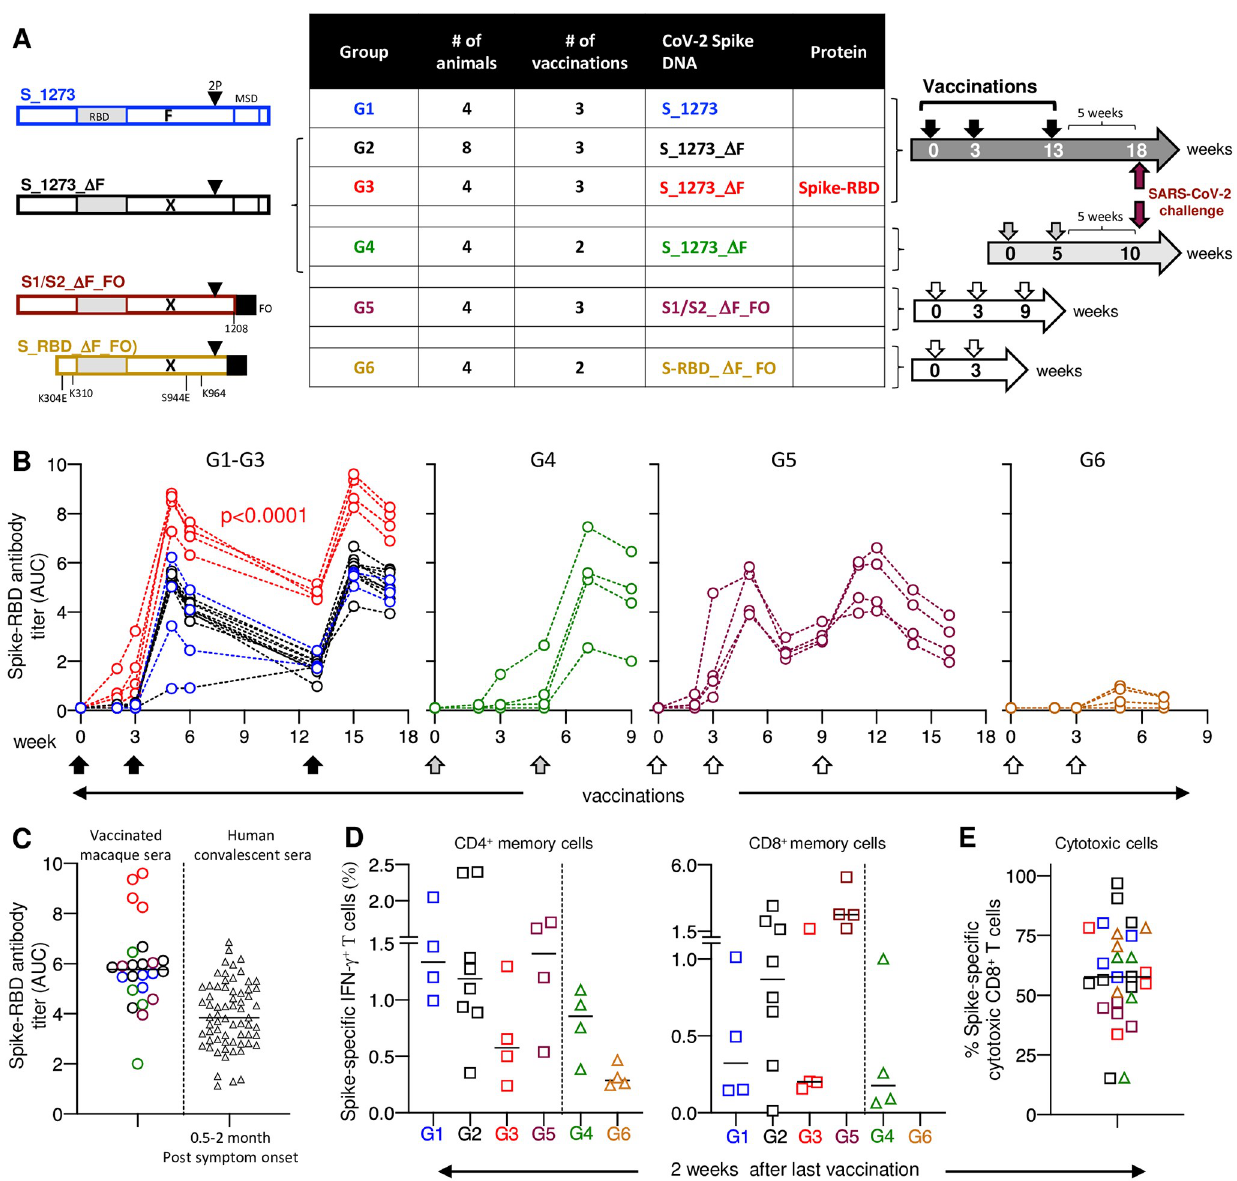
Fig 1. Vaccination-challenge study in macaques. ( A ) Cartoon depicts the Spike immunogens produced from the different DNA-based vaccines and the vaccination scheme of the 6 vaccine groups. The animals from G1-G4 were challenged 5 weeks after the last vaccination (indicated by maroon arrow). Blood was collected at different time points after each vaccination. ( B ) Anti-Spike-RBD antibodies were measured over time by ELISA in the vaccinated macaques and shown as AUC. P values is from ANOVA. Titers reached after the 3 rd vaccination correspond to median model fit endpoint titers of 6 logs for the DNA+Protein group (G3) and 5.1 logs for the DNA-only groups (G1, G2, G5). ( C ) Anti-Spike-RBD responses from macaques after the last vaccination were compared to levels measured in SARS-CoV-2 convalescent human sera (N = 66) collected at between 0.5 to 2 months post symptom onset. The same in-house ELISA was used for the macaques and human samples. ( D ) Spike-specific IFN- γ + T cell responses measured 2 weeks after the last vaccination. Squares represent (G1, G2, G3, G5) samples collected 2 weeks after the 3 rd vaccination; triangles (G4, G6) denote samples collected 2 weeks after the 2 nd vaccination. Spike-specific cellular memory responses are shown as % of memory CD4 + (left panel) and as % of memory CD8 + (right panel) T cell subset. Median values are indicated. ( E ) The fraction of Spike-specific cytotoxic (Grz + and/or CD107 + ) IFN- γ + CD8 + T cells from the samples shown in panel D.